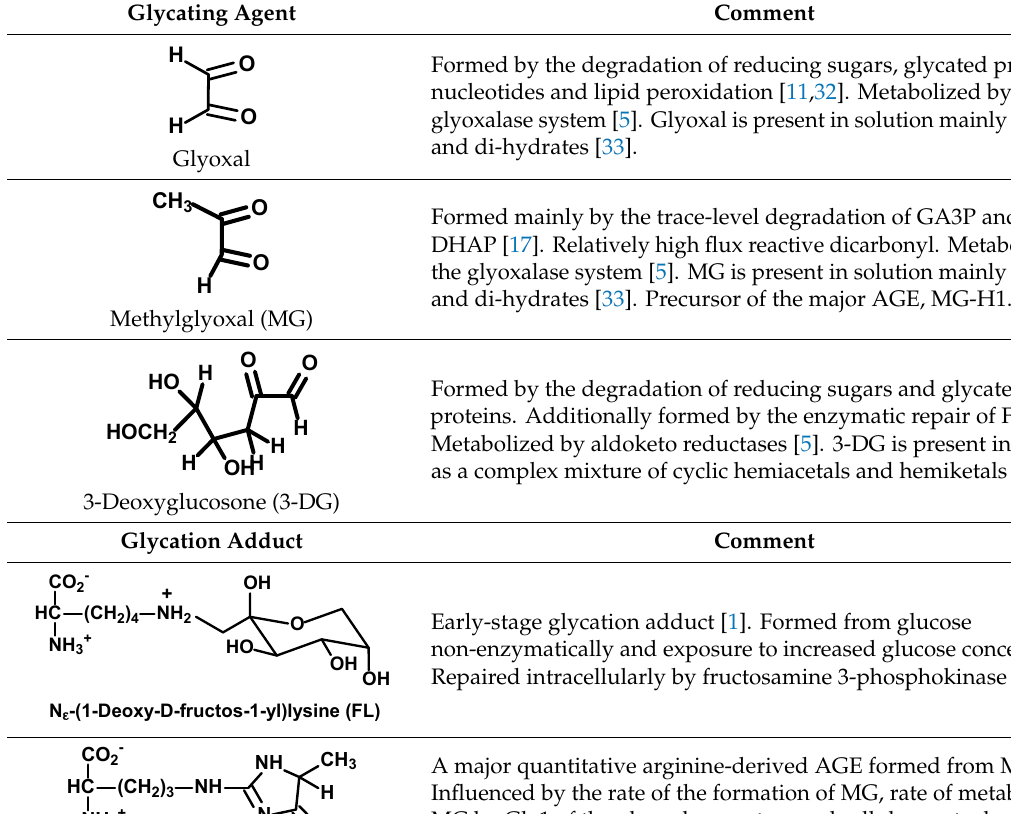
Table 2. Early-stage glycation adducts and advanced glycation endproducts. Table 1. Early-stage glycation adducts and advanced glycation endproducts. Table 1. Early-stage glycation adducts and advanced glycation endproducts. Table 1. Early-stage glycation adducts and advanced glycation endproducts. Table 1. Early-stage glycation adducts and advanced glycation endproducts. Table 1. Early-stage glycation adducts and advanced glycation